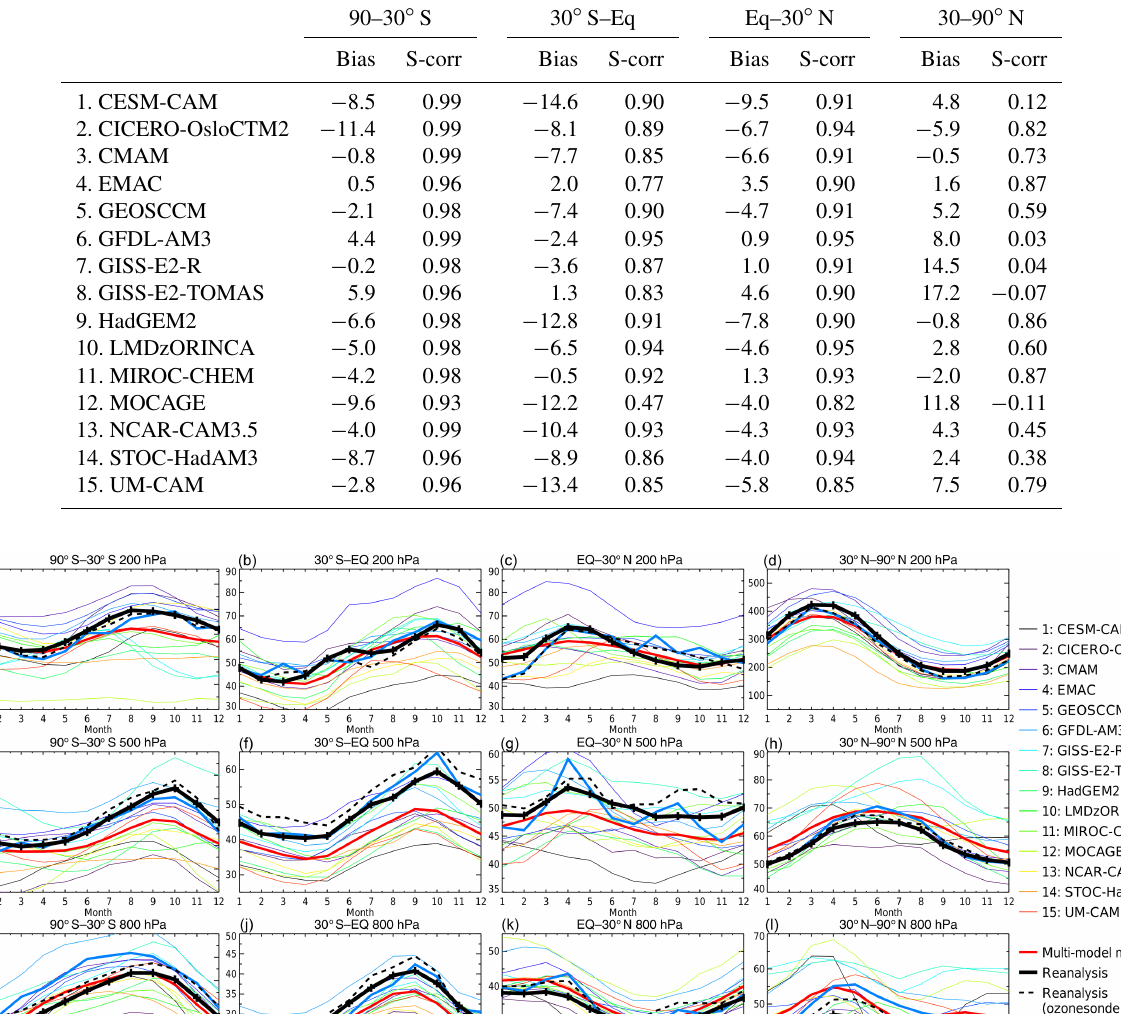
Table 5. ACCMIP models minus reanalysis comparisons of the mean ozone concentrations at 500hPa. Units of bias are ppb.